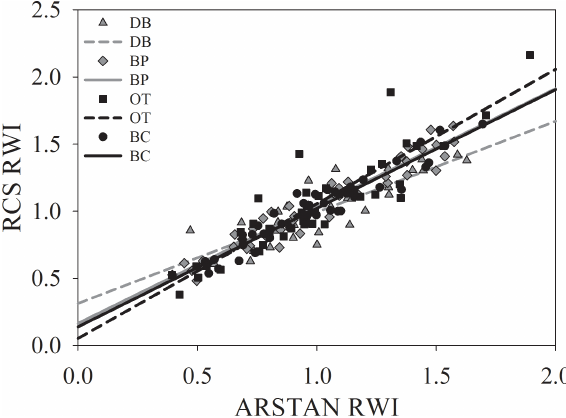
Figure 3. Relationship between site-level ring width indices calcu- lated using RCS detrending and ARSTAN.